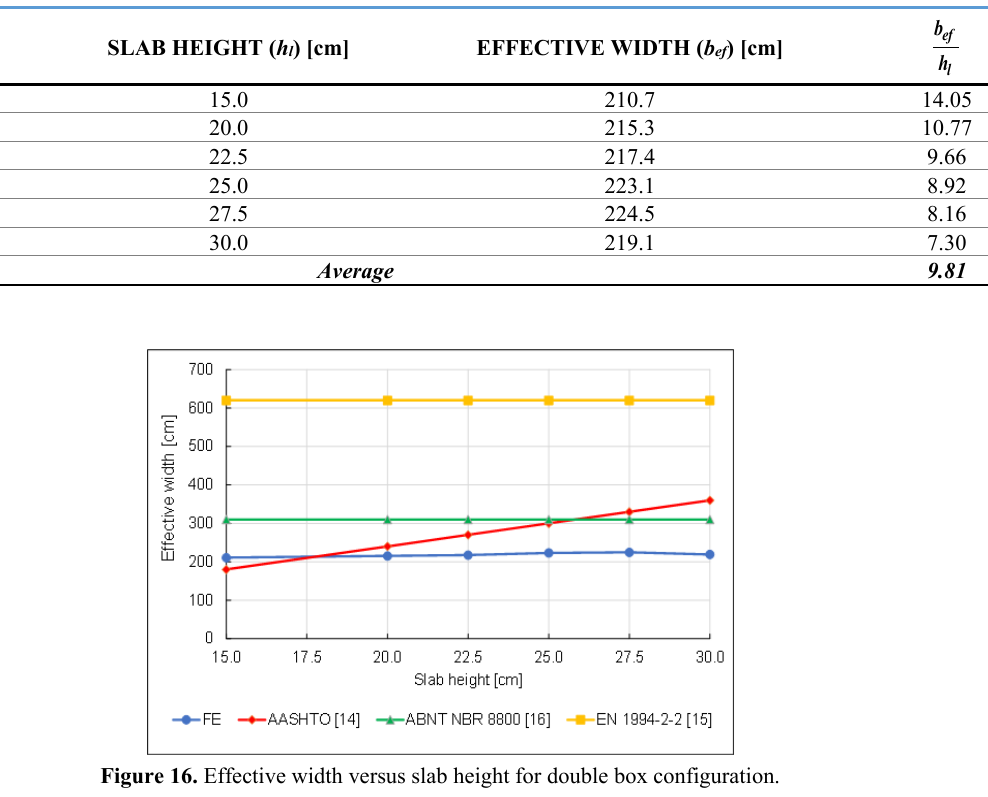
Table 7. Relationship between the effective numerical width and the slab height for the double box con figuration.